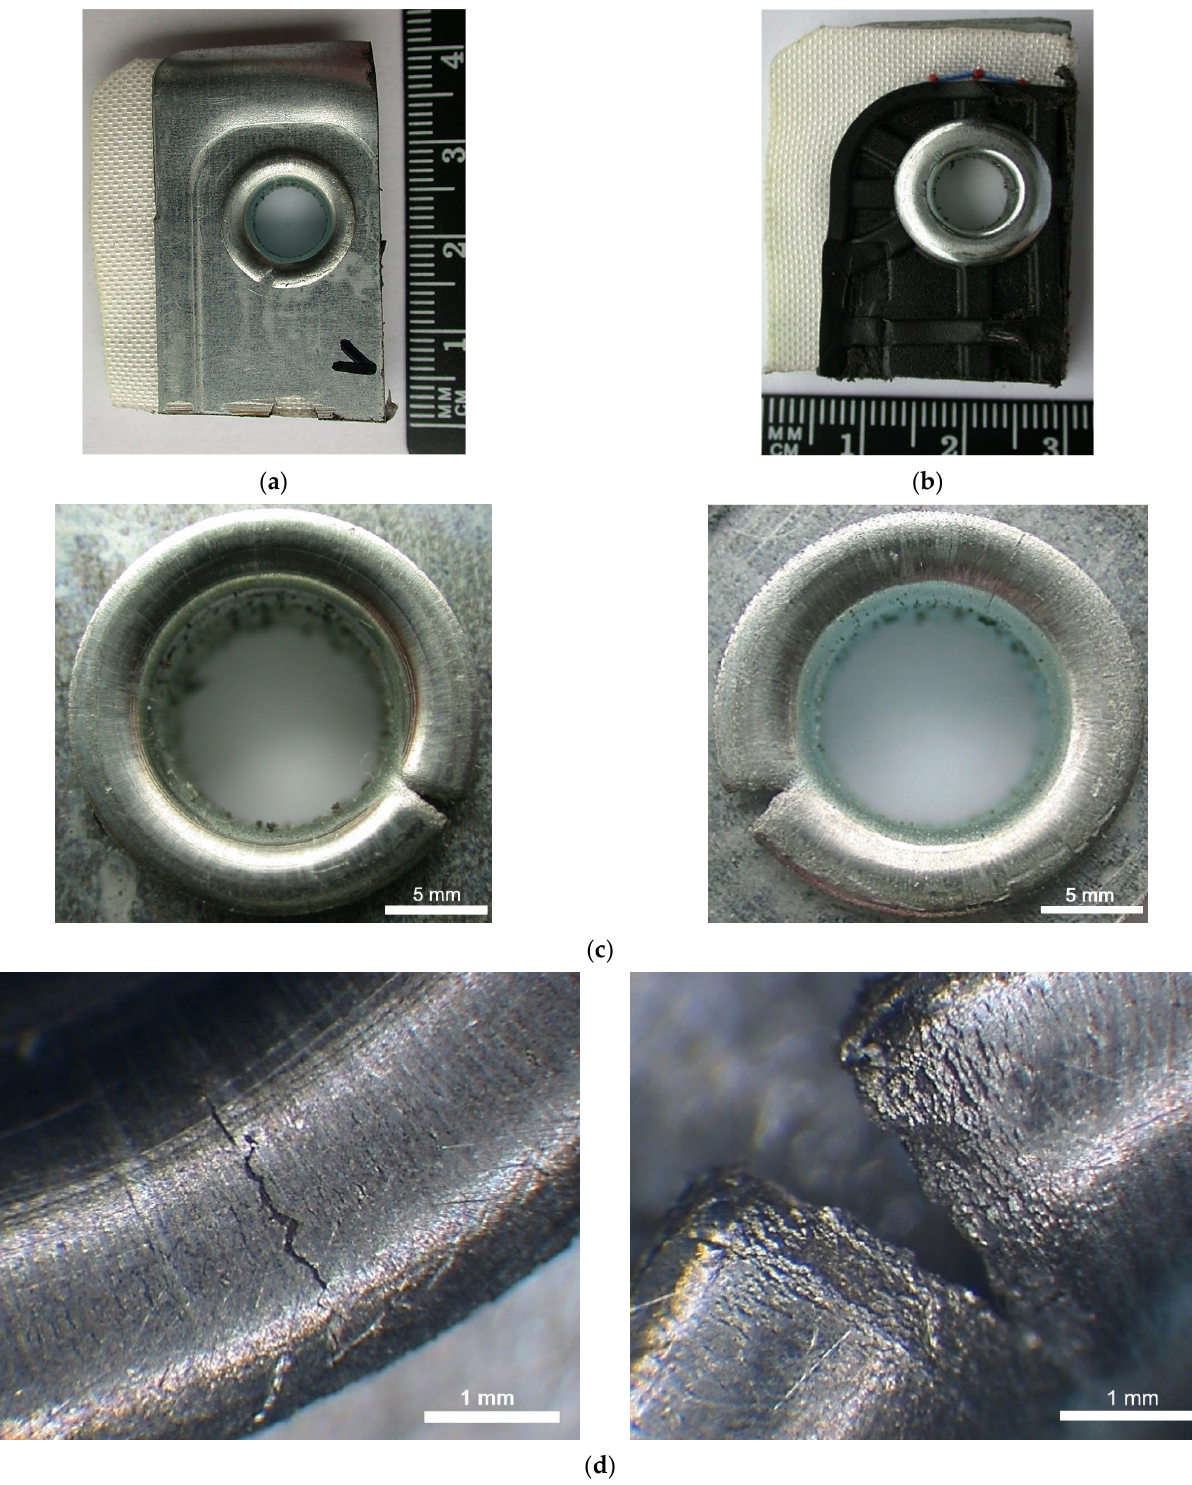
Figure 9. Macroscale image of rivets after rupture ( a ) cross ‐ section of airbag module with visibly broken rivet—top side of module), ( b ) cross ‐ section of airbag module—bottom side of module, ( c ) image of the broken rivet, ( d ) fracture surface of broken rivet after forming process.